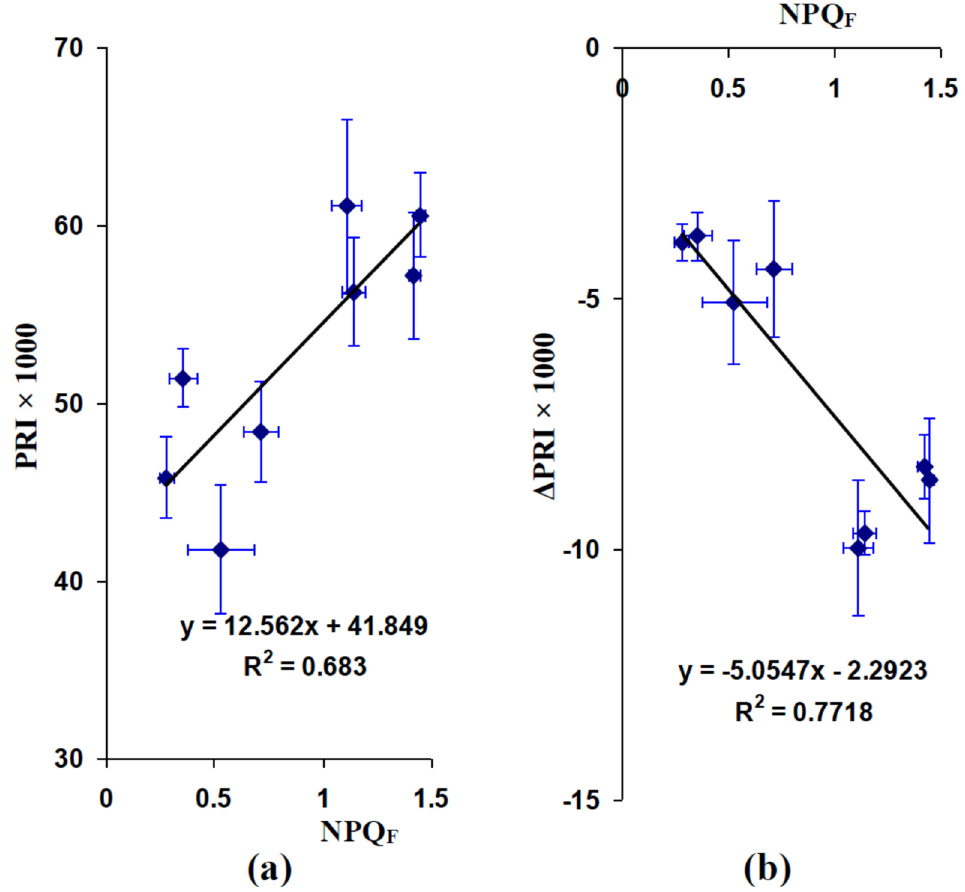
Figure 7. Scatter plots between NPQ F and PRI ( a ) and between NPQ F and Δ PRI ( b ) in experiments with water shortage. K W = 12.562 and K Δ W = − 5.0547 are linear regression coefficients in the plots ( a ) and ( b ), respectively. Average values of parameters and standard errors from Figure 6 were used. R 2 is the determination coefficient. Bars show standard errors.